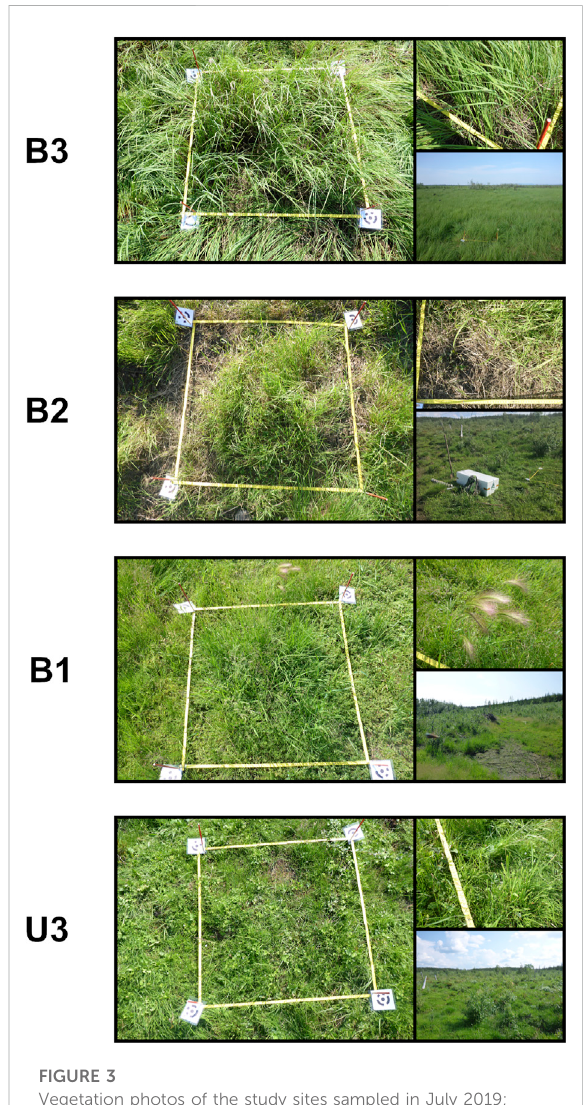
FIGURE 3 Vegetation photos of the study sites sampled in July 2019; each site comprises a 1 by 1 m plot photo (left), a vegetation detail photo (top right) and a landscape photo (bottom